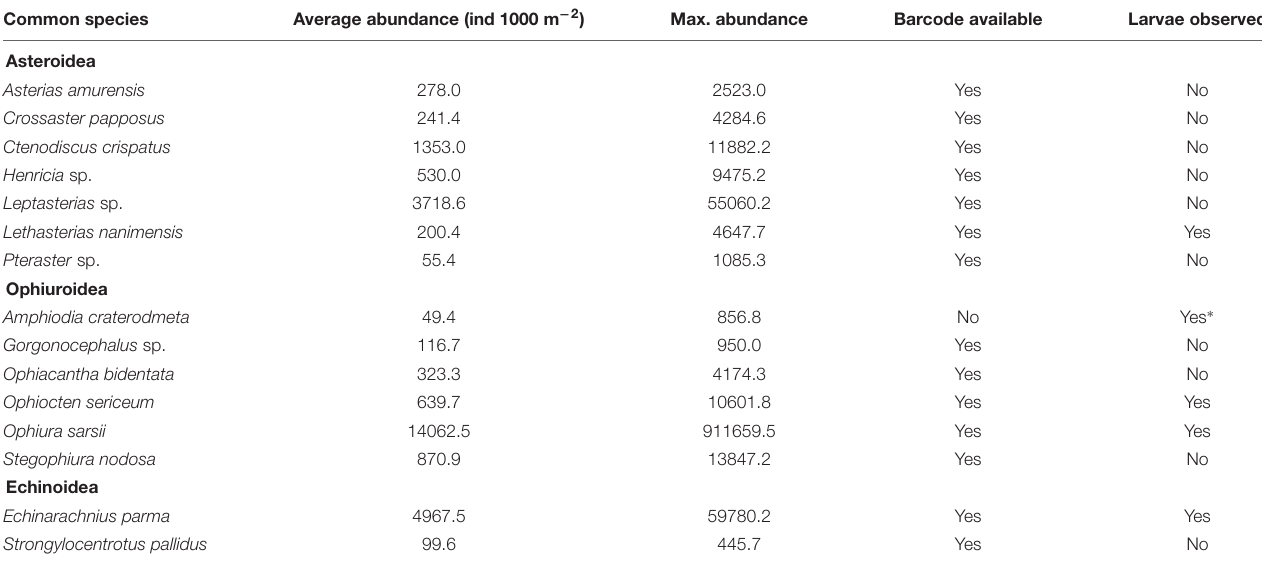
TABLE 5 | Most abundant echinoderm species within the benthos of the Chukchi Sea. Common